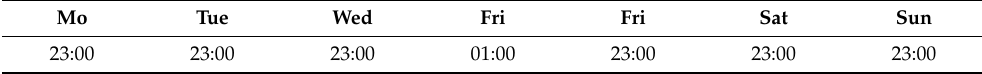
Figure 2. Hits “suicide” and “depression” for Germany–trend-seasonal decomposition. Table 4. Average hits–suicide